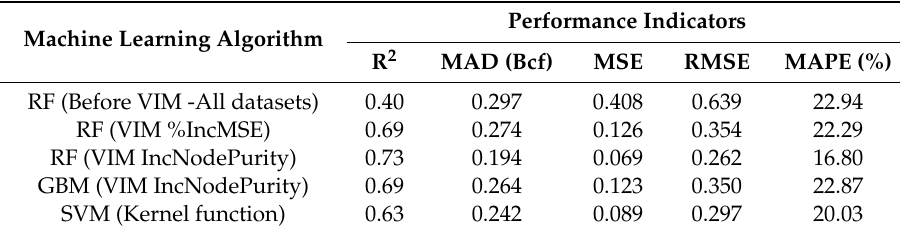
Figure 12. Boxplot of absolute percentage error for supervised learning models before and after variables importance method (VIM). Table 4. Comparison of performance indicators of various supervised learning models.